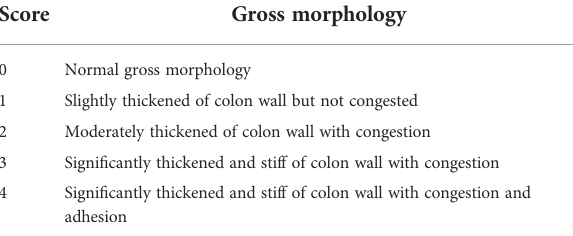
TABLE 2 Scoring criteria of gross morphology of colon.